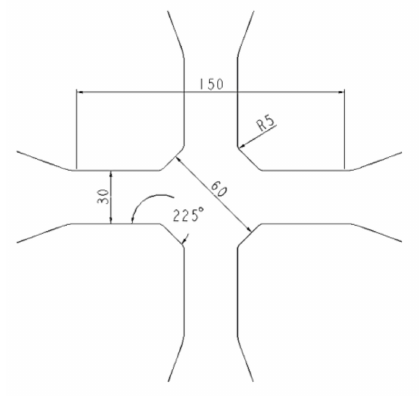
Figure 3. Cruciform sample geometry used for the simulation and experiment (mm).